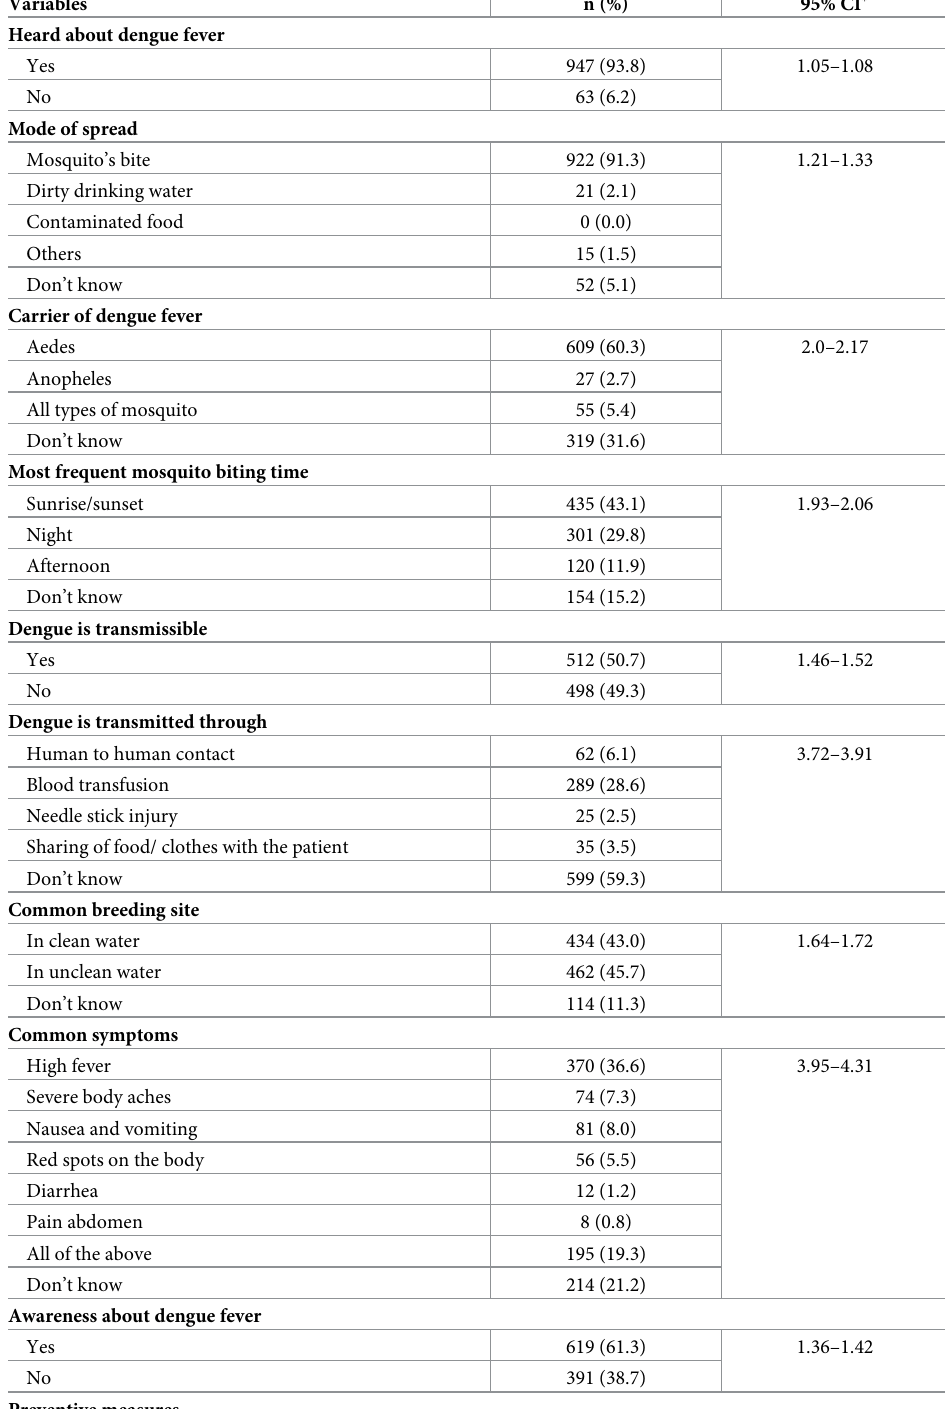
Table 2. Knowledge, attitude and preventive practice (KAP) towards dengue fever in different regions of